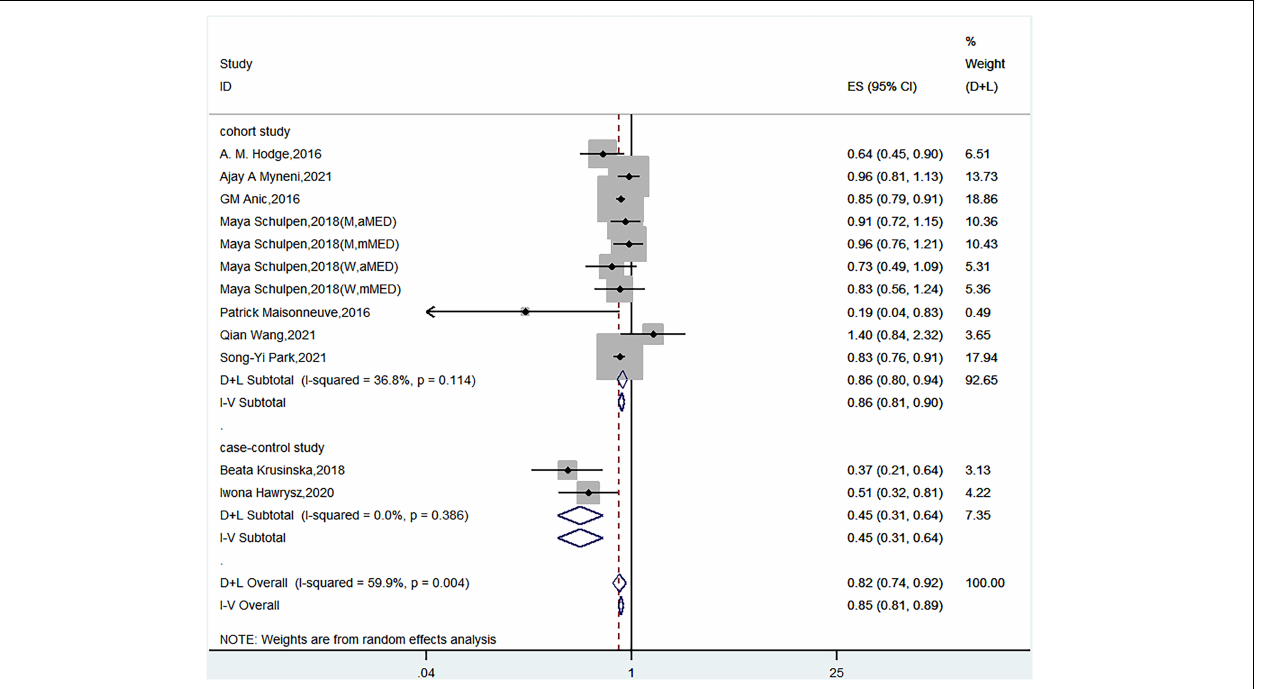
FIGURE 2 | The relationship between Mediterranean diet patterns and the risk of lung